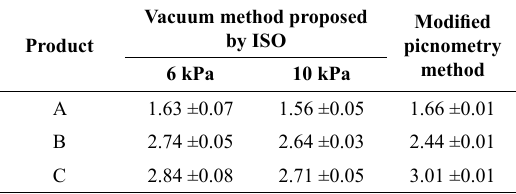
Table 7. Comparison among WA values (%) obtained from the vacuum method at different vacuum pressures and the modified picnometry